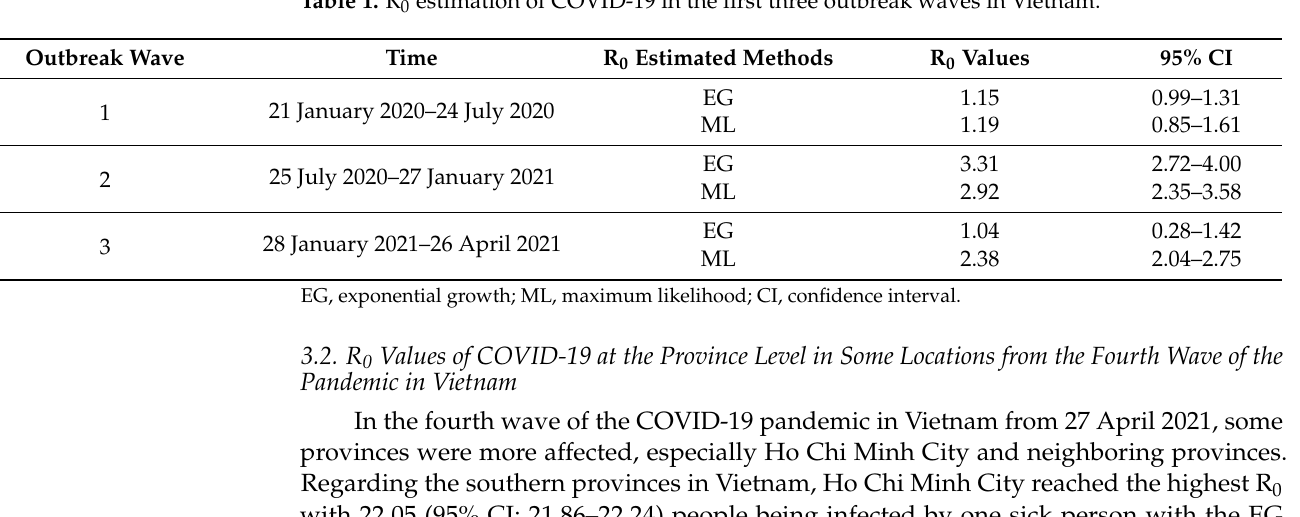
Table 1. R 0 estimation of COVID-19 in the first three outbreak waves in